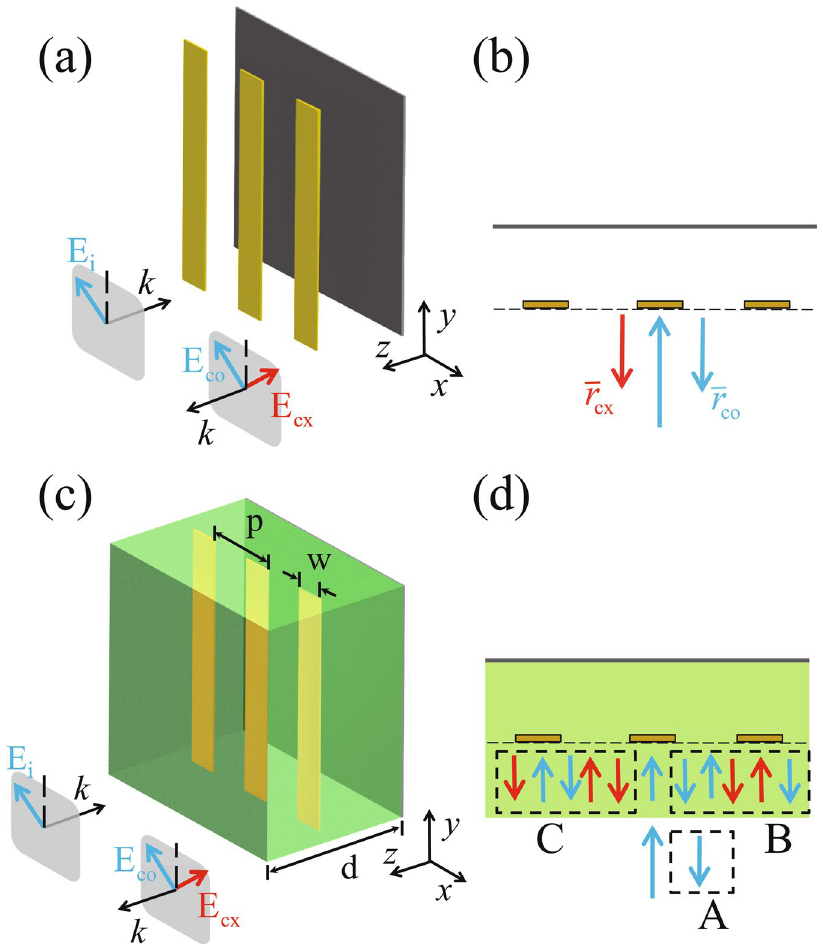
Figure 1. Illustrations on the design and operating principle of the proposed device. ( a ) Schematics of a half- wave plate with a narrow bandwidth. ( b ) Analytic model for treating the half-wave plate depicted in ( a ). ( c ) Schematics of the proposed half-wave plate with a broad spectral bandwidth. ( d ) Analytic model for treating the half-wave plate depicted in ( c ). Note that the blue and red colors are in correspondence to cases where the polarization angles are − 45 degrees and 45 degrees with respect to the grating